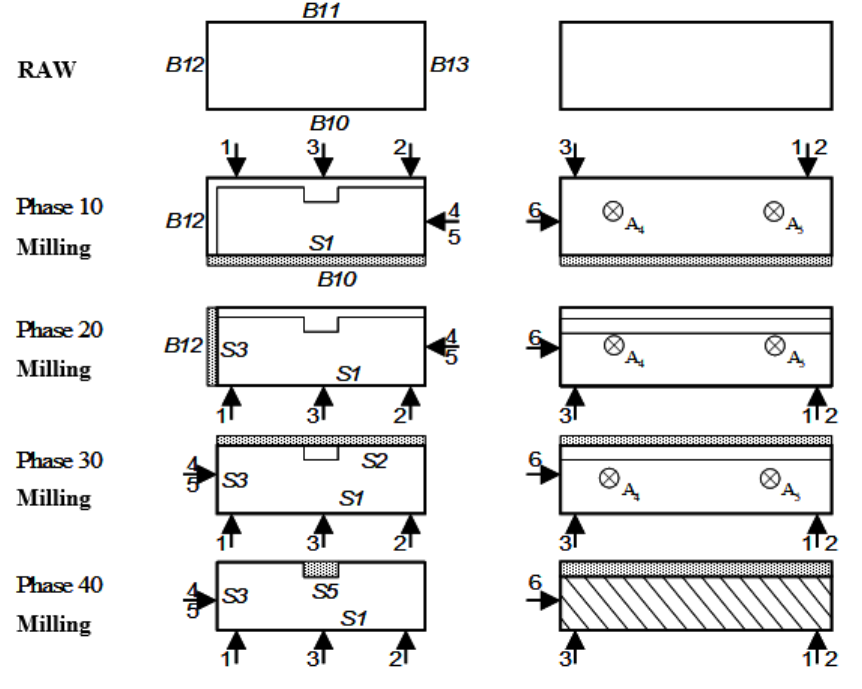
Figure 6. Machining process.